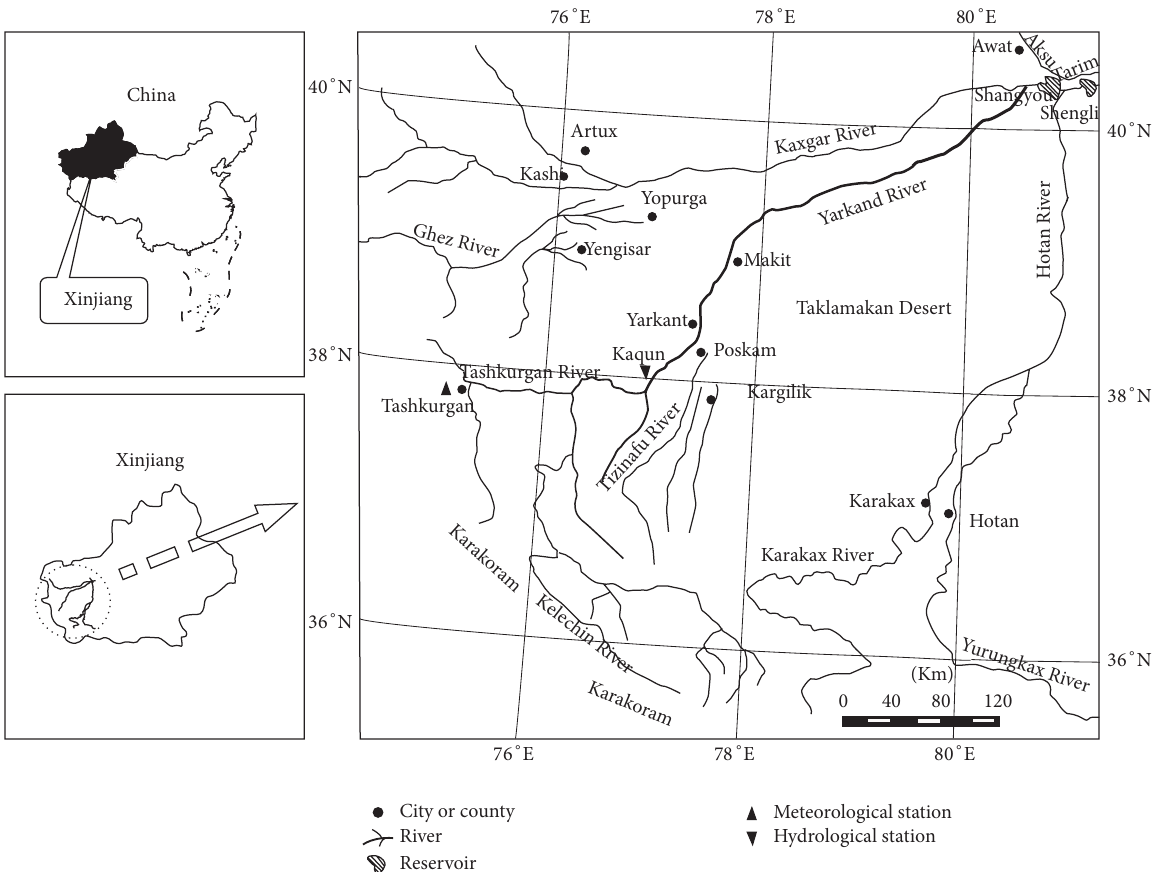
Figure 1: Location of the Yarkand